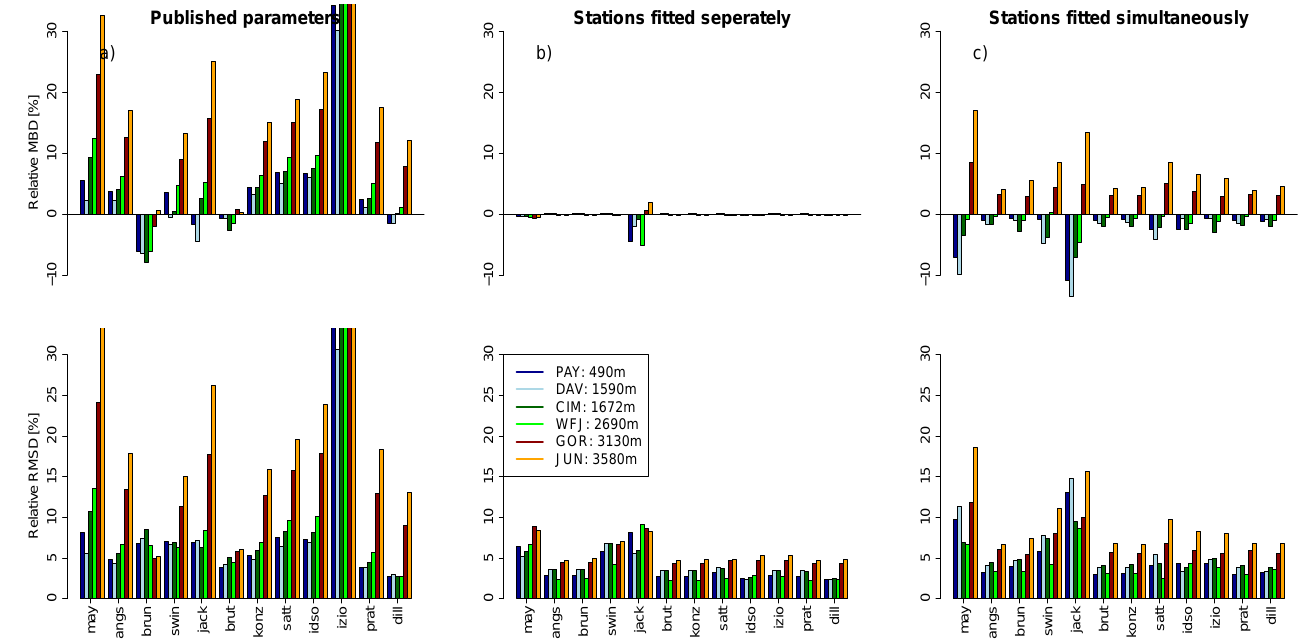
Fig. 7. MBD and RMSD for the LDR parameterizations using (a) the published parameter values, (b) the parameter values when fitting the parameterizations to each station separately and (c) when fitting all stations together